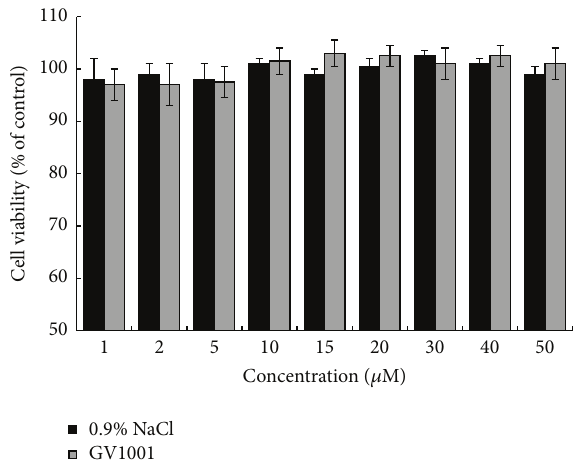
Figure5: Effects of GV1001on viability of hDPSCs.Thecells (2 × 10 5